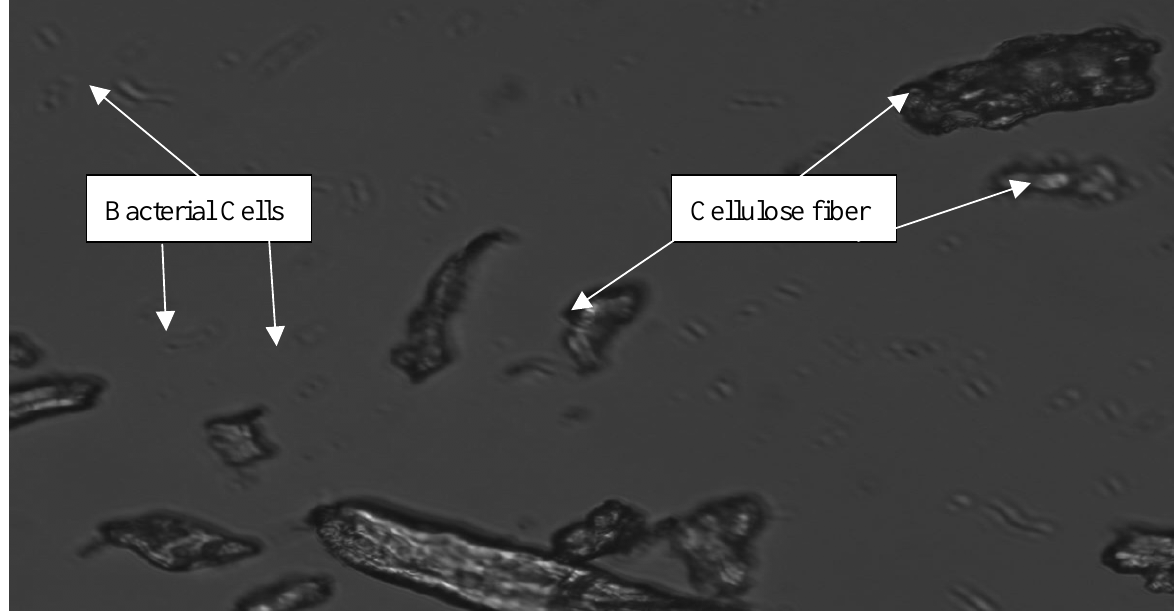
Figure 3. Microscopic observation of C. hutchinsonii grown on cellulose revealed no level of cell adhesion by this microorganism to the cellulose fibers. Picture taken after 96h incubation when most of the enzyme activity was